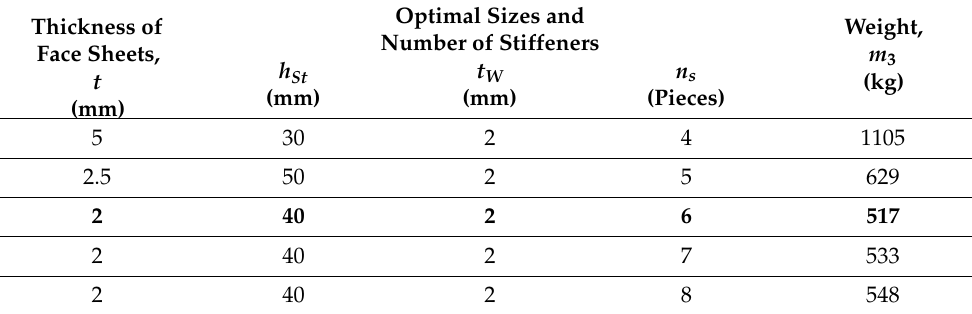
Table 5. Result of the weight optimization.